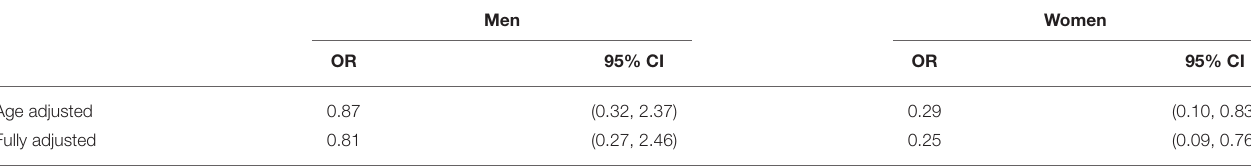
TABLE 4 | Odds of ANA positivity among adult ( ≥ 20 years of age) statin users vs. non-users in NHANES 1999–2004 ( n =